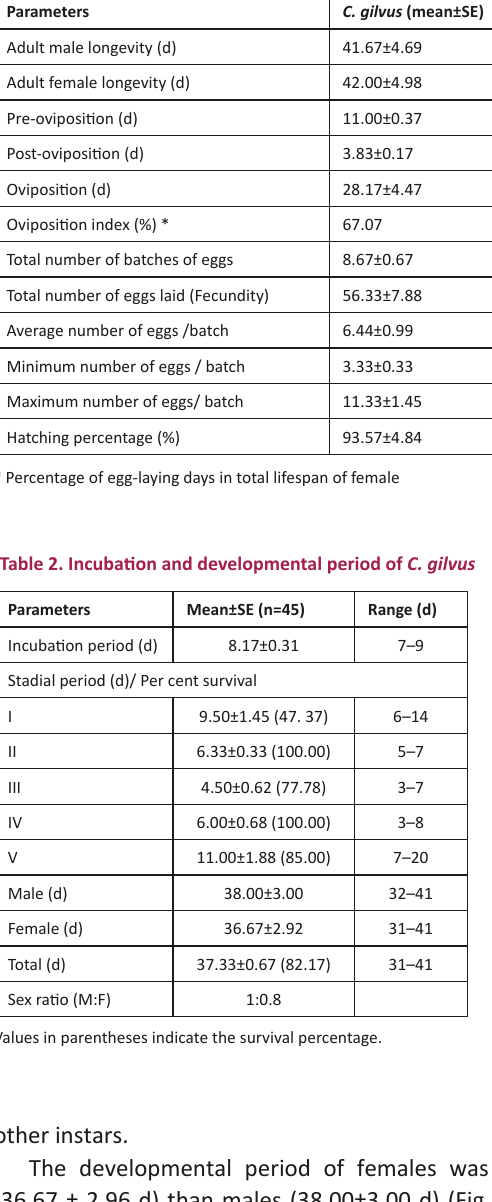
Table 1. Longevity and oviposition pattern of C. gilvus (n = 45) Parameters